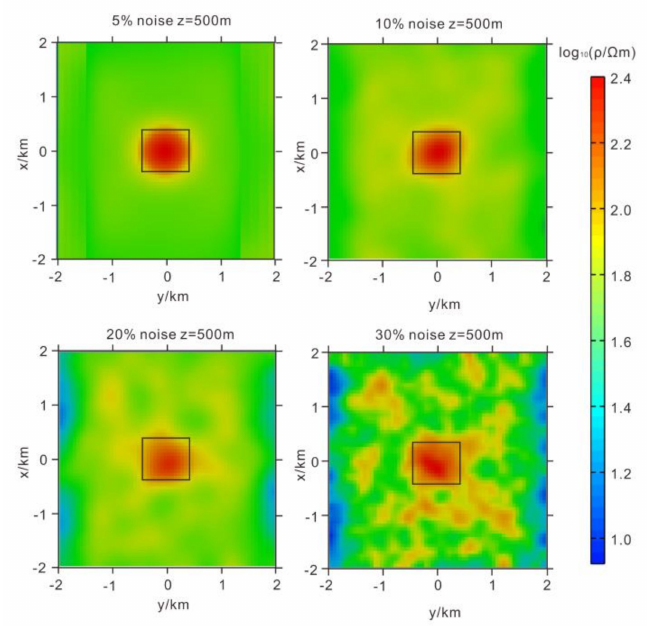
Figure 5. Horizontal sectional views of the inversion results at different noise levels (z = 500 m).